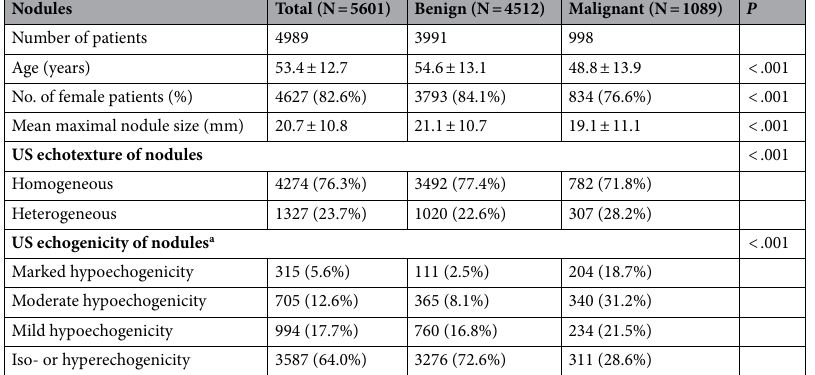
Table 1. The mean size of the nodules was 53.4 ± 12.7 mm (range, 10–100 mm). Of the 5601 thyroid nodules, 4512 (80.6%) were diagnosed as benign and 1089 (19.4%) as malignant. The 1089 malignant nodules included